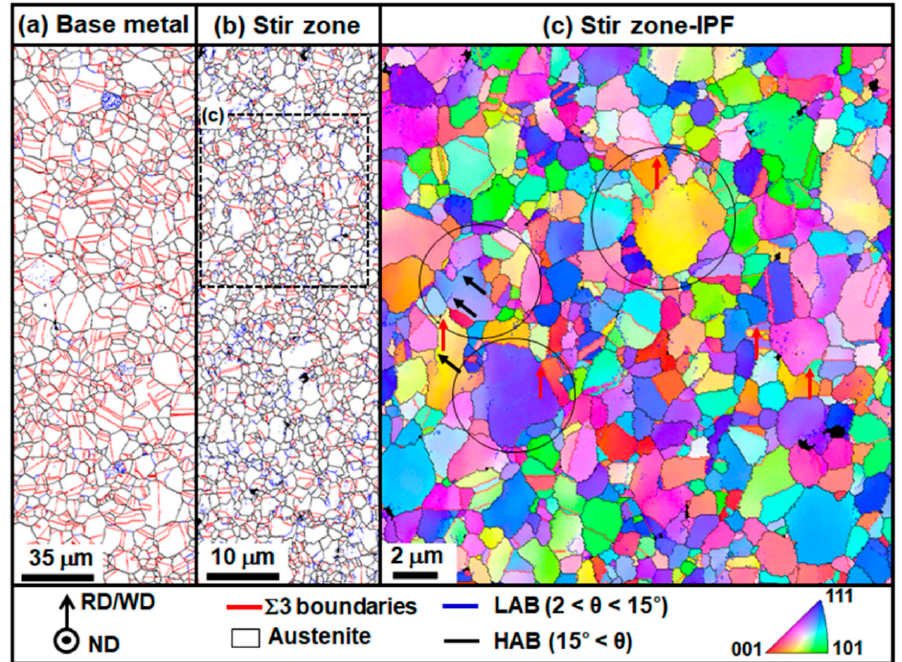
Figure 1. Electron backscattered di ff ractometer (EBSD) grain boundary and phase maps of ( a ) base metal, ( b ) stir zone, and ( c ) inverse pole figure enlarged area of ( b ) stir zone sample. ND: normal direction, WD: welding direction, RD: rolling direction.